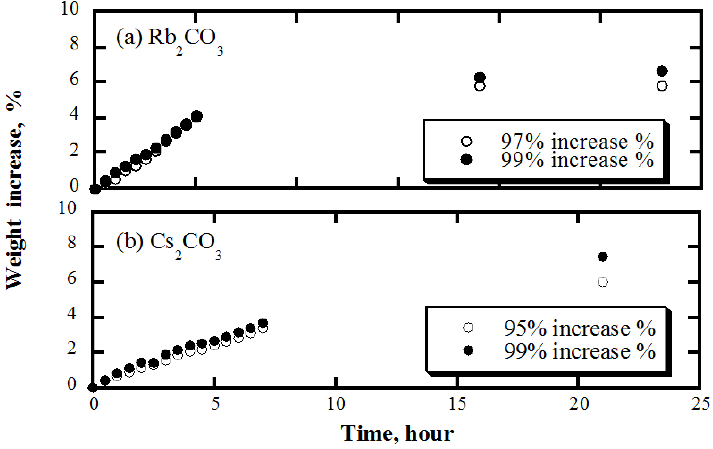
Figure 7. Weight increase of ( a ) Rb carbonate and ( b ) Cs carbonate powders depending on the purity, reprinted with permission from [41]. Copyright 2010